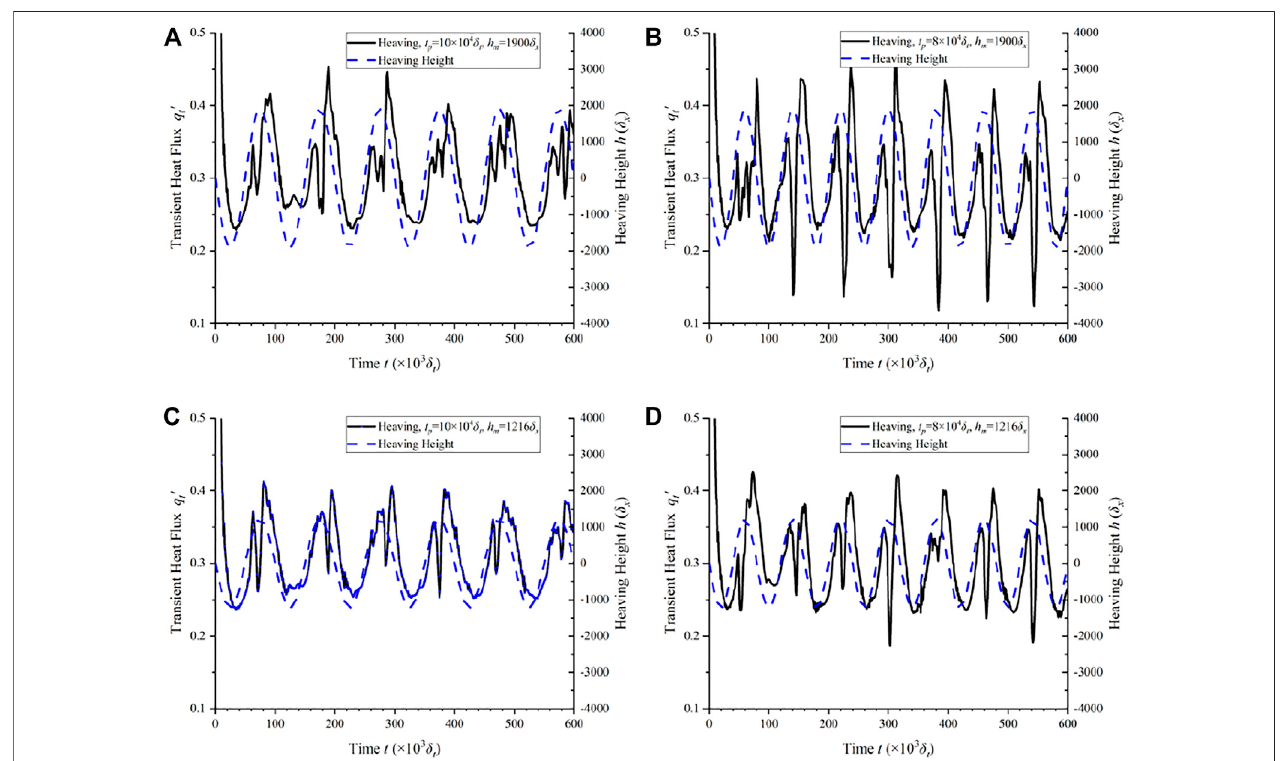
FIGURE15| Transientheat fl uxwithdifferentheavingparametersatthenucleateboilingregime(Ja (cid:1) 0.143). (A) Heavingperiod t p (cid:1) 10 × 10 4 δ t ,maximumheaving height h m (cid:1) 1900 δ x , (B) t p (cid:1) 8 × 10 4 δ t , h m (cid:1) 1900 δ x , (C) t p (cid:1) 10 × 10 4 δ t , h m (cid:1) 1216 δ x , and (D) t p (cid:1) 8 × 10 4 δ t , h m (cid:1) 1216 δ x